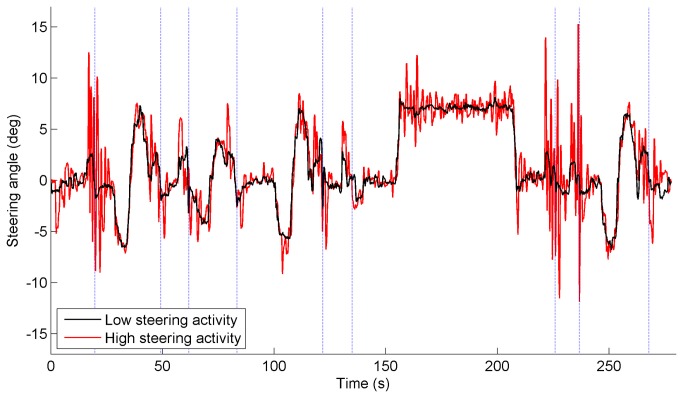
Steering angle versus time of two selected participants in session 4.One selected participant had very active steering, whereas the other had very smooth steering. The steering angle was filtered with a cutoff frequency of 2 Hz. Positive = steering to left, negative = steering to right. The dotted vertical lines indicate when the participant passed one of the nine static obstacles.